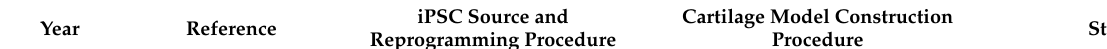
Table 2. Summary of iPSC-derived OA-related 3D model